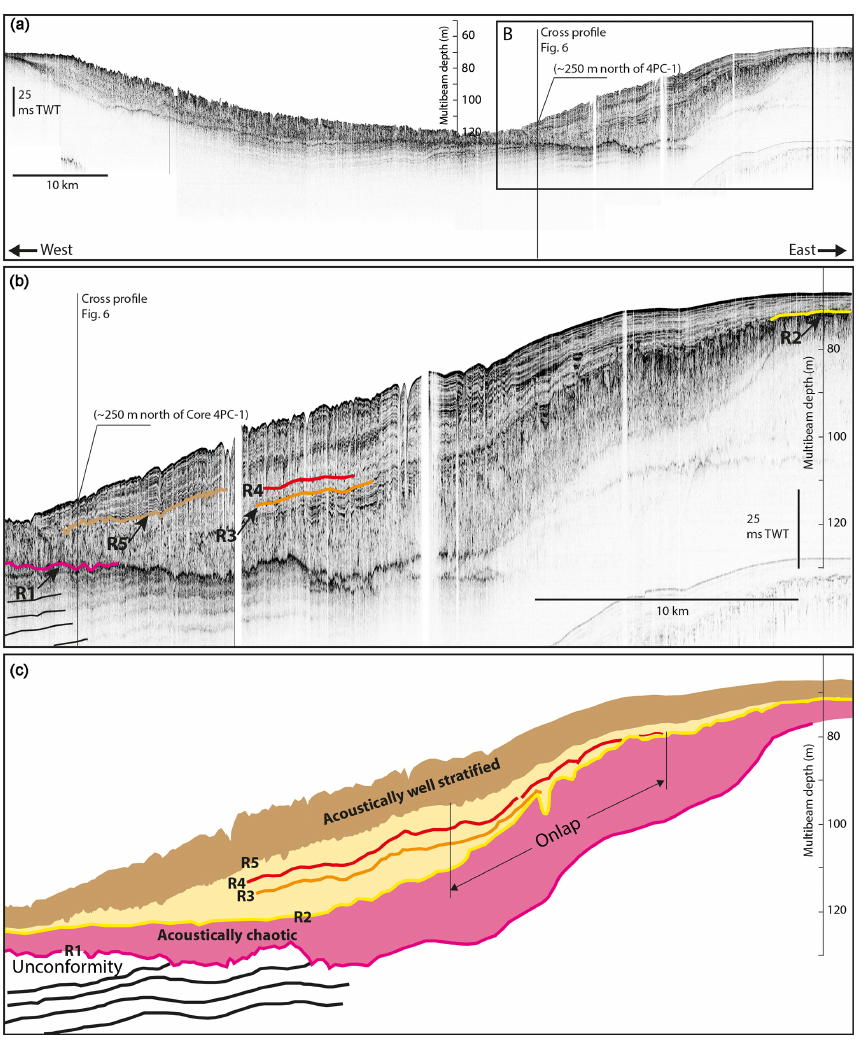
Figure 5. Chirp sonar sub-bottom profiles along transect 4. (a) The full extent of transect 4 as shown in Figs. 1 and 4. The location of the crossing profile on which the core 4-PC1 site is located is marked by a black line. (b) Detail of the eastern side of the Herald Canyon transect 4. The identified reflectors R1–R5 discussed in the text are marked. (c) Division of acoustic units based on the identified reflectors in panel ( b